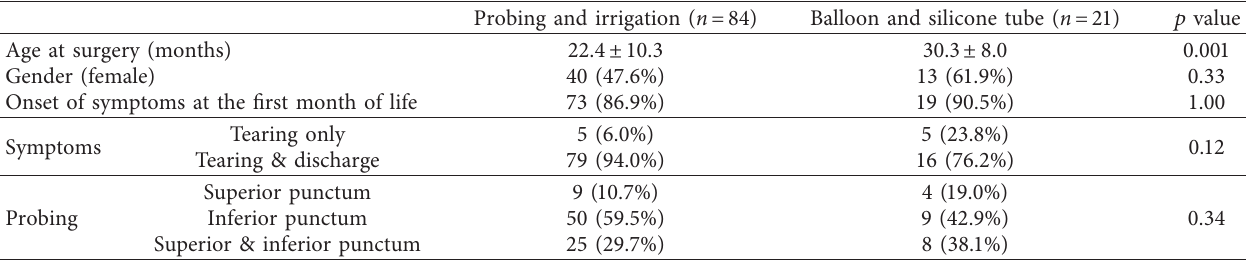
Table 1: Baseline characteristics between patients with probing and irrigation and those with balloon catheter dilation and silicone tubing.